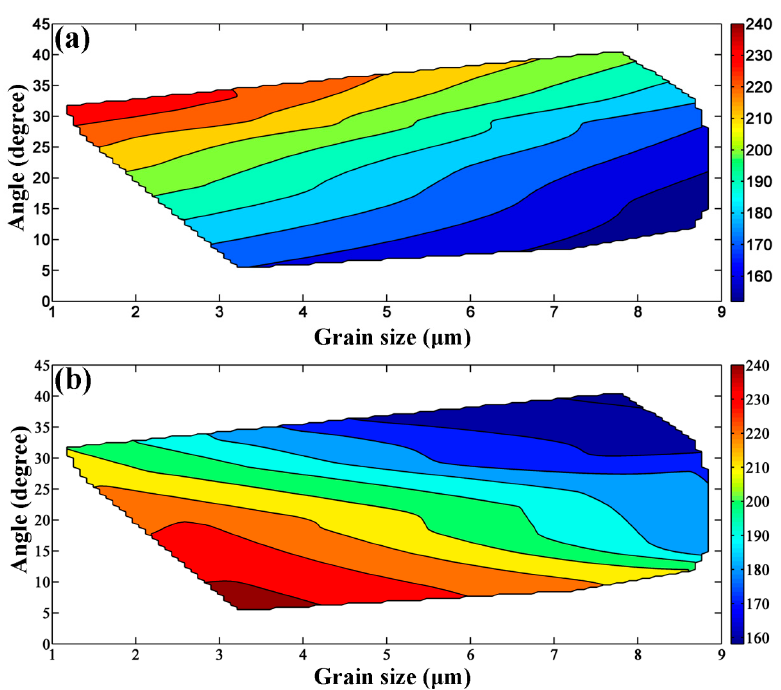
Figure 9. Room-temperature yield strength contour map of the CECed ZK61 alloy rods as a function of the grain size and θ : ( a ) tension; ( b ) compression.